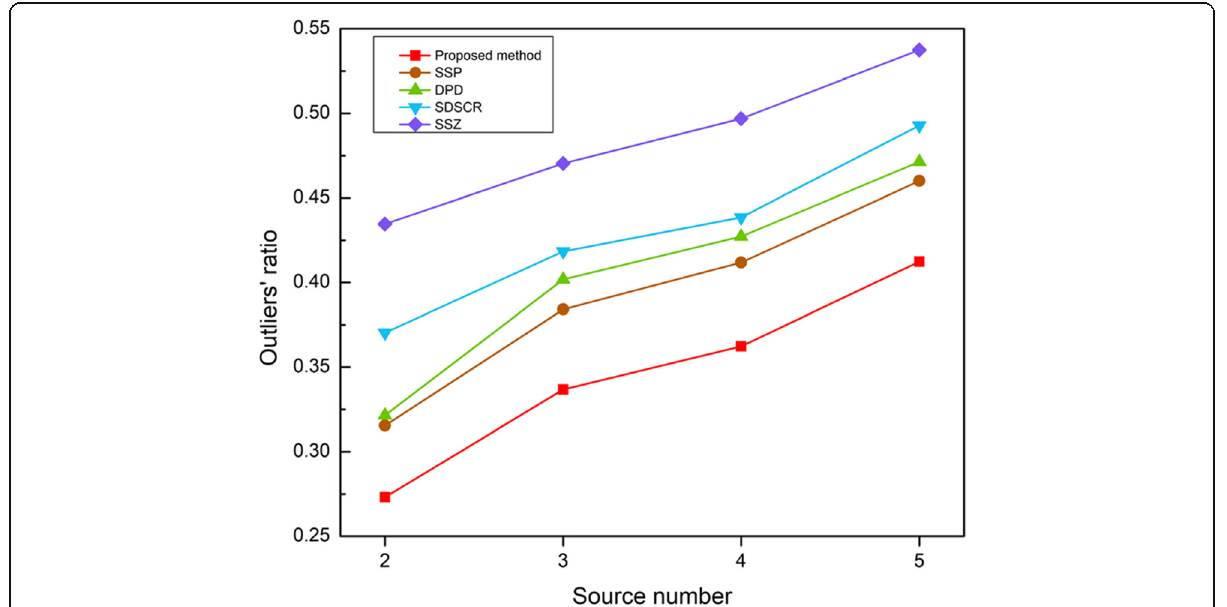
Fig. 8 Statistical analysis for outliers ’ ratio with different number of sources, RT60 = 150 ms, separation between adjacent sources is